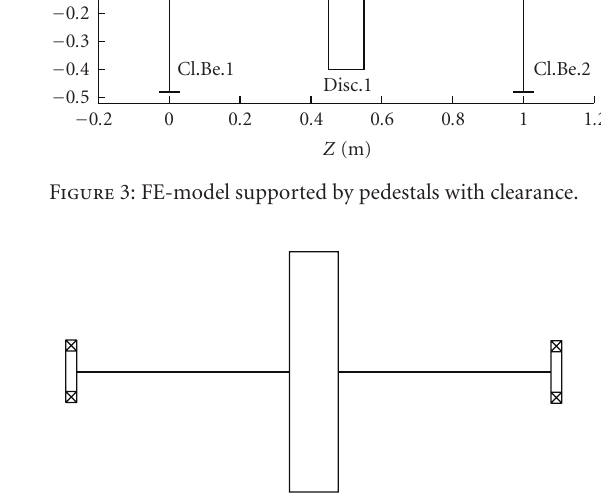
Figure 4: Je ff cott rotor model supported by pedestals with clear-